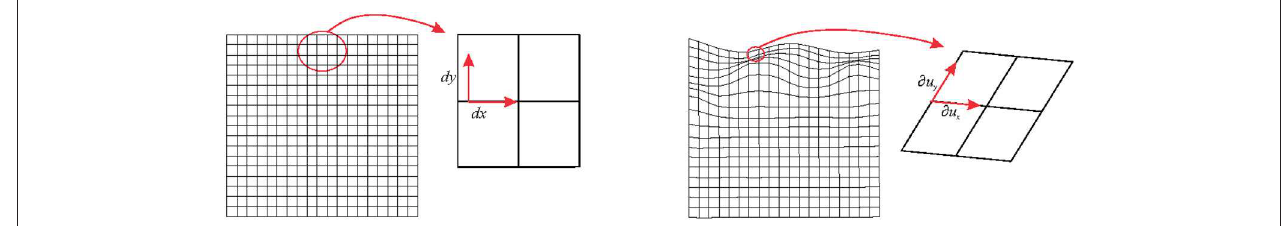
FIGURE 1 | Left panel : a non-affine deformation of a regular square. Right panel : a global non-affine deformation is shown. Infinitesimally, the deformation can be considered as